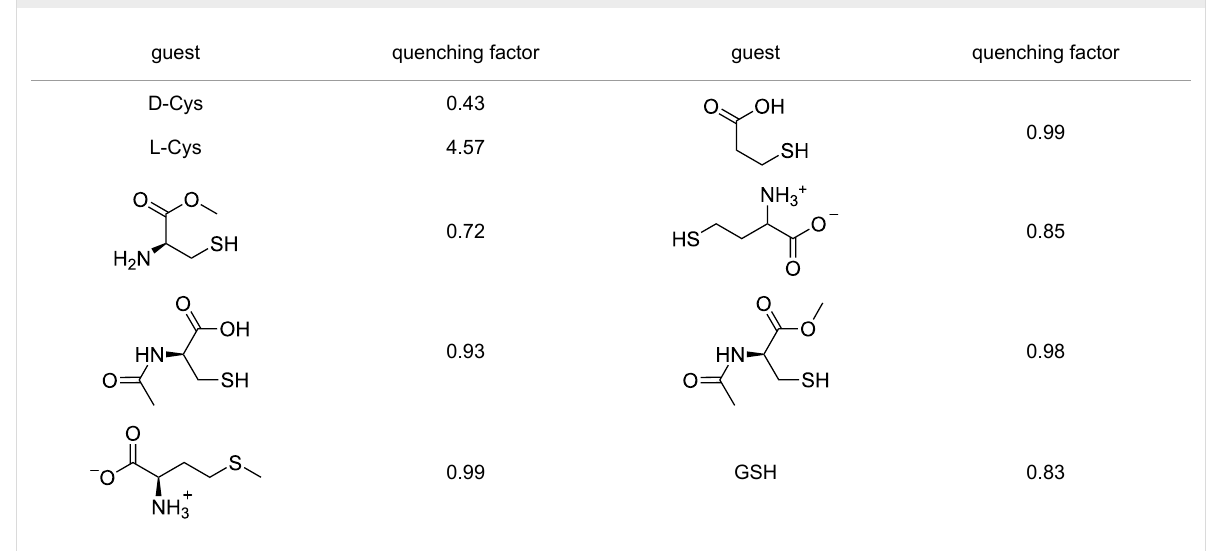
Table 3: The quenching factor of Cd 2+ – ACAQ with various